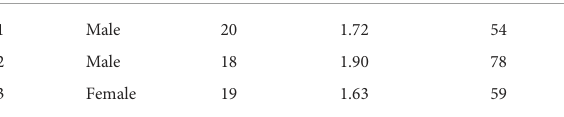
TABLE 1 Demographic details of the